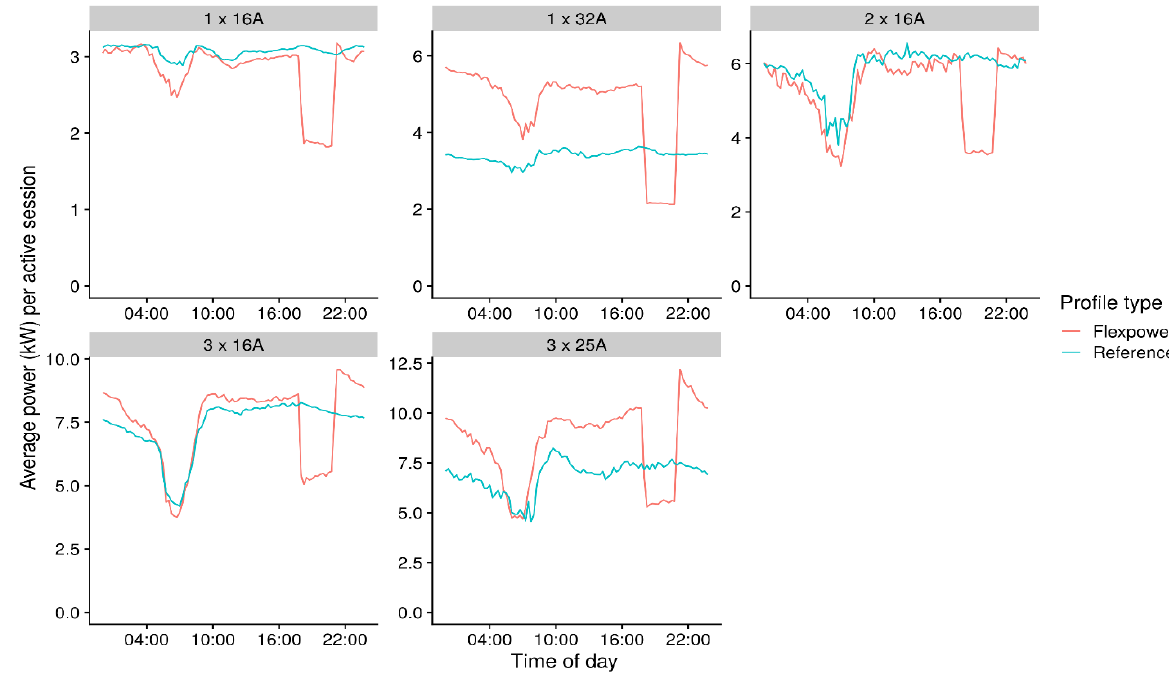
Figure 2. The average power over the day for the different vehicle categories during charging. The resolution of the graph is 15 min, which is limited by the resolution of the data.